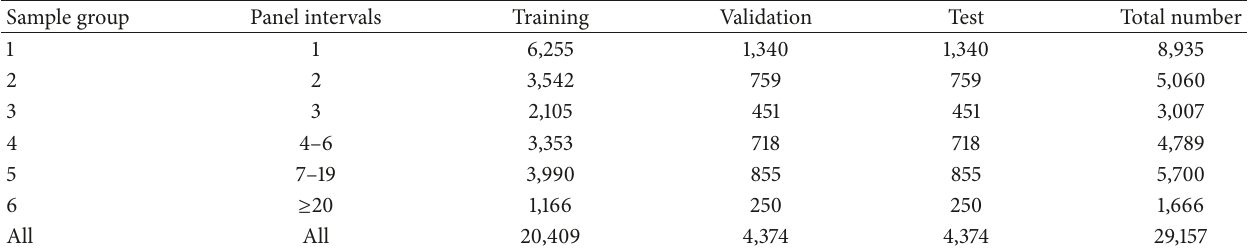
Figure 8: (a) Mean loss performance for 20 different lambda ( 𝜆 ) values for samples with required panel between 7 and 19. (b) Feature selection based on NCFS with the lowest loss lambda for samples with required panel between 7 and 19. Table 5: Samples sizes of training, validation, and test data.